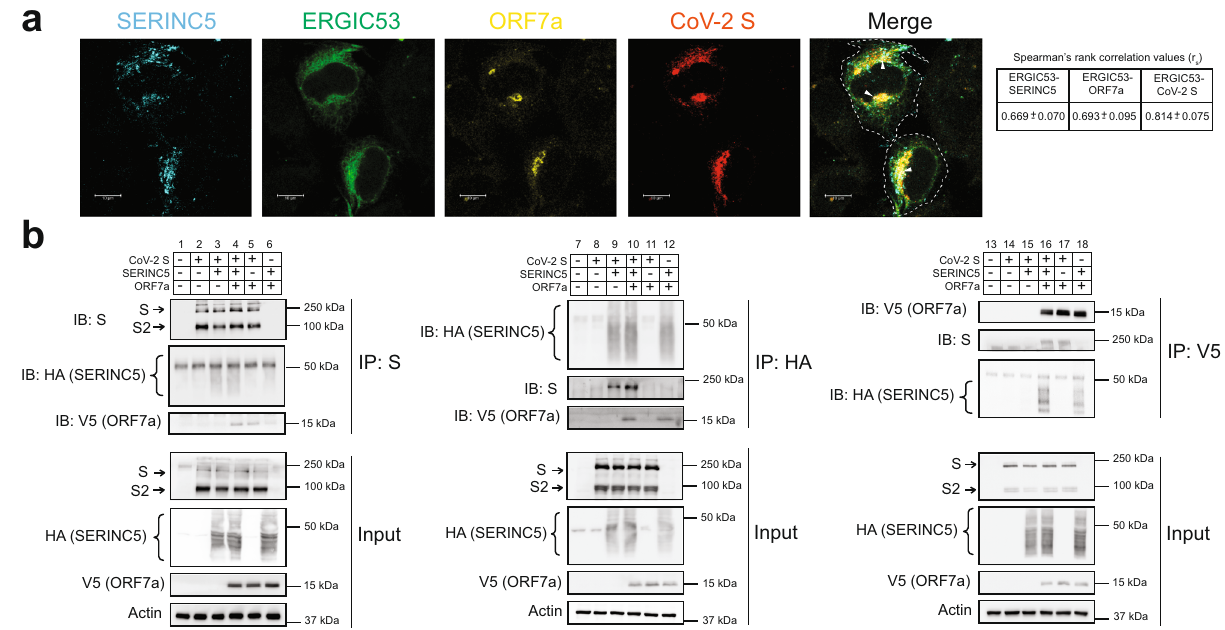
Fig. 7 SARS-CoV-2 Spike, ORF7a and SERINC5 co-localize at the ERGIC and physically interact. a SARS-CoV-2 Spike (S), ORF7a, SERINC5 co-localize at the ERGIC. AD-293 cells cotransfected with plasmids expressing SERINC5-HA, EGFP-ERGIC53, SARS-CoV-2 ORF7a and SARS-CoV-2 S were subjected to immunostaining. Images were acquired using 63×/1.4 oil-immersion objective with a Leica TCS SP8 confocal microscope. Arrow heads indicate areas of colocalization, and the dotted line outlines the edges of the cells. Shown are confocal images revealing co-localization of SERINC5, SARS-CoV-2 S and ORF7a with ERGIC53 cellular marker (arrows). Scale bar = 10 µ m. Representative deconvolved single Z-section images are shown. Table on the right shows quantitative analyses for co-localization between SERINC5, SARS-CoV-2 S or ORF7a and ERGIC53. Spearman ’ s rank correlation values ( r s , mean ± SD) of a region of interest (ROI) de fi ned by the presence of EGFP-ERGIC53 signal were calculated using the ImageJ (FIJI) Coloc2 plugin from 3 different images each from a different experiment. b SARS-CoV-2 S, ORF7a, SERINC5 form a complex. 293T cells were cotransfected with SARS-CoV-2 S, SERINC5, SARS-CoV-2 ORF7a or empty vector as indicated. Cells were harvested 48 h post transfection and lysates were immunoprecipitated with anti- SARS-CoV 2 S, anti-HA and anti-V5 antibodies followed by immunoblot analyses probing with anti-SARS-CoV-2 S, anti-HA (SERINC5), anti-V5 (SARS- CoV-2 ORF7a), and anti-Actin antibodies. Representative immunoblotting results are shown. Uncropped blots are in Source Data. All results are shown for n = 3 independent experiments. (SARS-CoV-2 ORF7a, ORF7a; SARS-CoV-2 S, S; SARS-CoV-2 Spike S2 subunit,